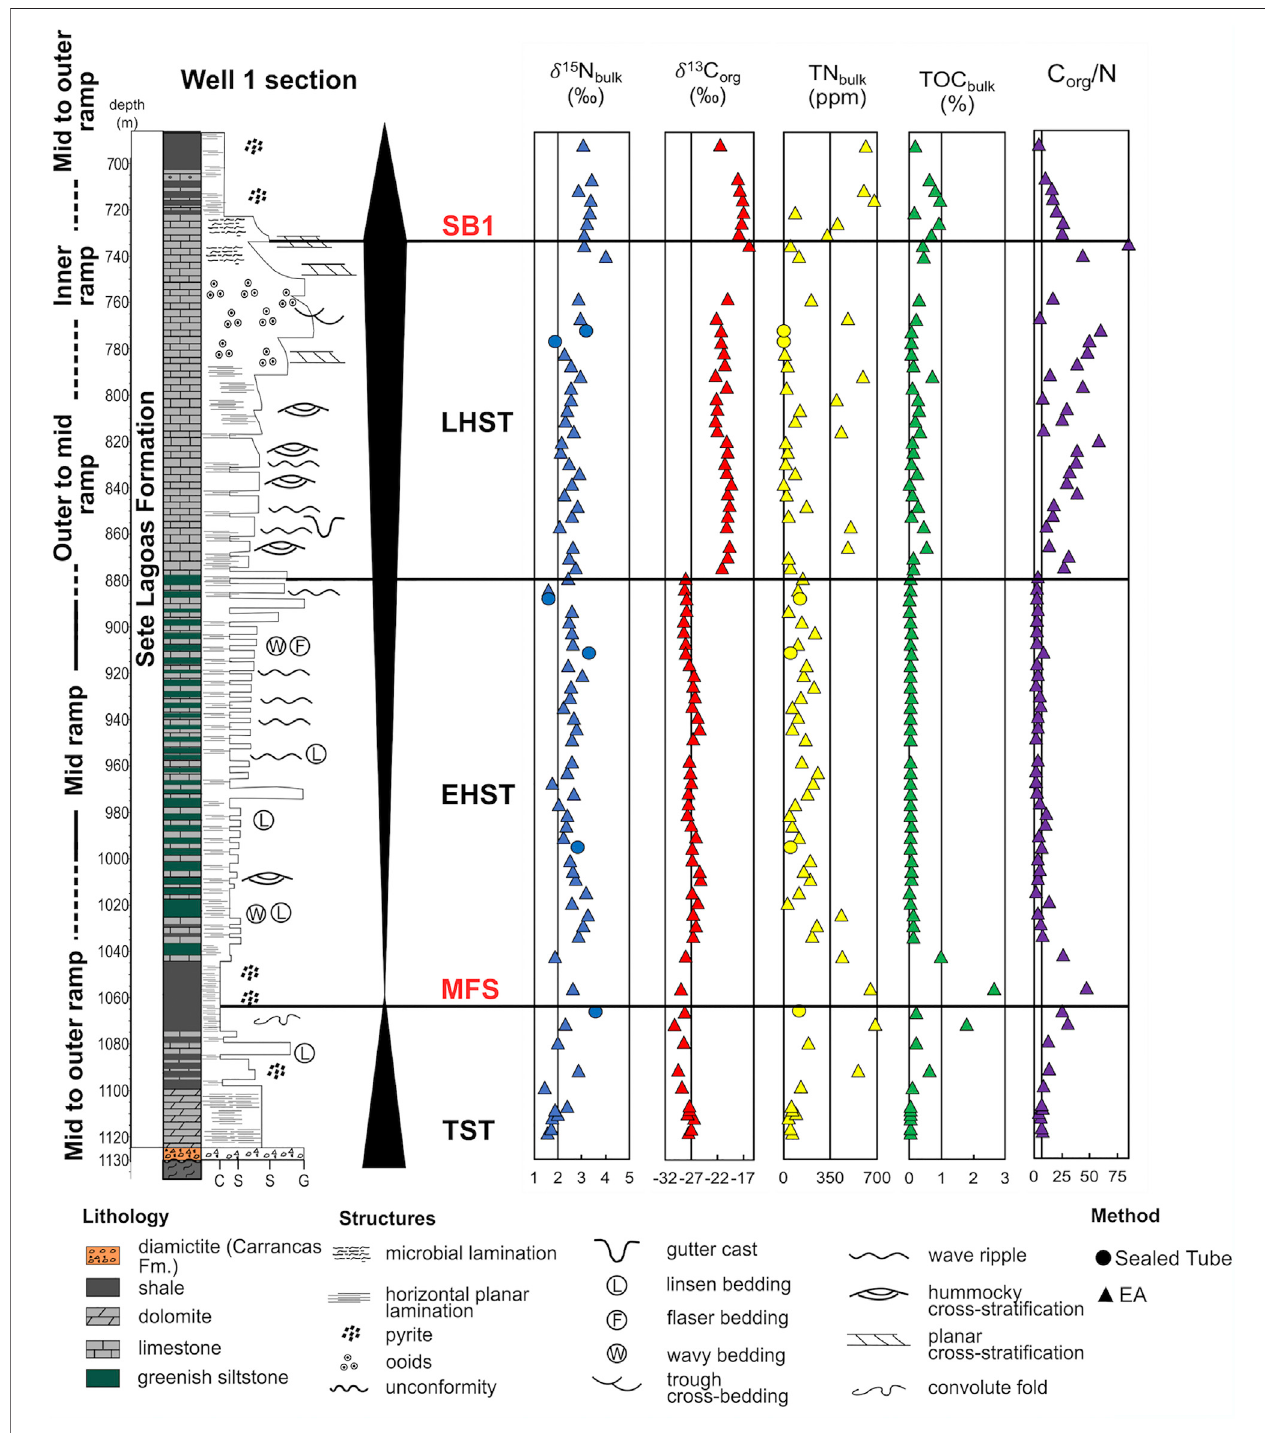
FIGURE 6 | Well1 section:Depositionalenvironments, lithologies,structures and sequencestratigraphyframework. δ 15 N datawas obtainedinthisstudy and δ 13 C org waspublishedbyCaetano-Filhoetal.(2021).TheaxisontheC org /Ncolumnis fi xedontheRed fi eldratio(6.6).Abbreviationsherearethesameastheonesusedin Figure4 second sequence of the Janu (cid:1) aria section, the resolution of sampling was 1 m. For the rest of the sections, the interval